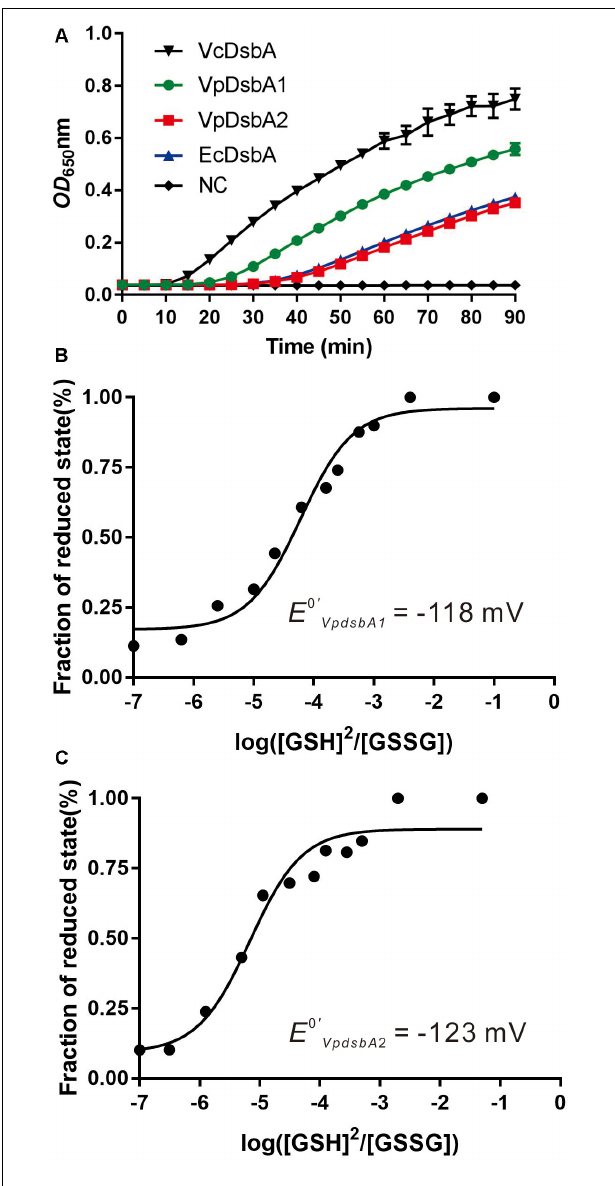
FIGURE 2 | Reductase activity and redox potential of VpDsbAs. (A) Insulin (170 µ M) and 0.33 mM DTT was incubated with 10 µ M of each DsbA protein. The reduction of insulin was measured by monitoring the increase in absorbance at OD 650 . Reaction without reductase protein is used as negative control (NC). (B,C) Characterization of the redox potential of VpDsbA1 (B) and VpDsbA2 (C) . Non-linear fit to the fraction of reduced VpDsbA at different ratios of reduced:oxidized glutathione. This fit was used to obtain the equilibrium constant K eq and the redox potential [calculated relative to the GSH/GSSG standard potential of –240 mV (Gilbert, 1995)]. The curve was fit to the averaged data from three replicate experiments.